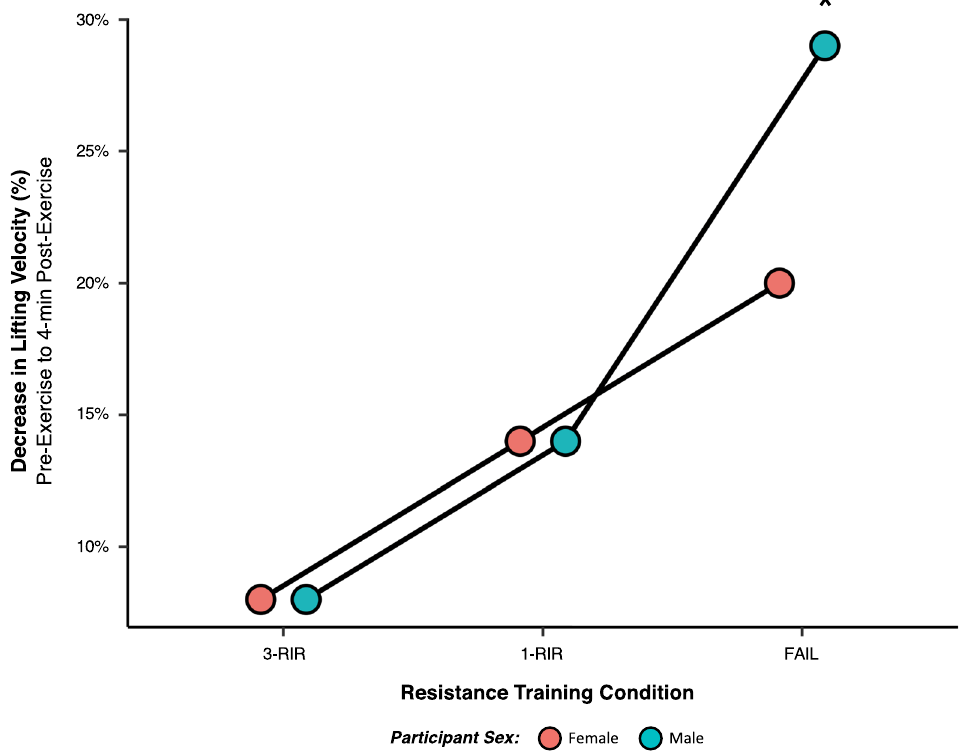
Fig. 4 Relationship between proximity-to-failure and acute neuromuscular fatigue. Data shown are expressed as a percentage decrease in lifting velocity with a fixed load from pre-exercise to 4 min post-exercise (displayed as a positive value to indicate an increase in neuromuscular fatigue) in response to six sets performed on the barbell bench press exercise to either momentary muscular failure (FAIL), 1-RIR, or 3-RIR. Accompanying SD values can be found in Table 3. *Denotes a statistically significant difference from female